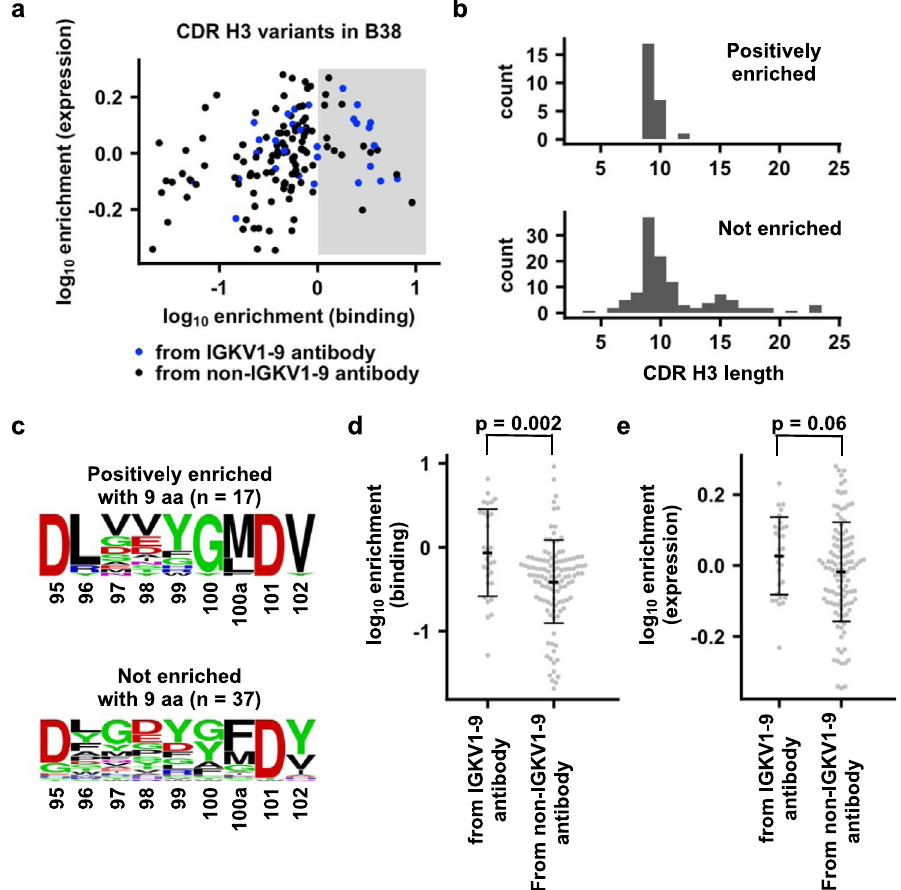
Fig. 4 Binding and expression pro fi ling of 143 CDR H3 variants in B38 antibody. a For each of the 143 CDR H3 variants, the enrichment in occurrence frequencies after FACS selections for binding to RBD and expression level are shown. Blue: CDR H3 variants that are derived from IGHV3-53/3-66 RBD antibodies that use IGKV1-9. Black: CDR H3 variants that are derived from IGHV3-53/3-66 RBD antibodies that do not use IGKV1-9. Shaded area indicates log 10 enrichment in binding >0. Data are from the average of n = 2 independent biological replicates. b The amino-acid length distribution of CDR H3 variants that are positively enriched in binding (log 10 enrichment in binding >0) or not (log 10 enrichment in binding ≤ 0) is shown. c Sequence logos are shown for CDR H3 variants with 9 aa (Kabat numbering) that are positively enriched or not enriched. d Comparison of log 10 enrichment in binding for CDR H3 variants from IGHV3-53/3-66 RBD antibodies that use IGKV1-9 and those that do not use IGKV1-9. e Comparison of log 10 enrichment in expression for CDR H3 variants from IGHV3-53/3-66 RBD antibodies that use IGKV1-9 and those that do not use IGKV1-9. d , e Two-tailed Student ’ s t -test was used to compute the p -value. Error bars represent standard deviations. The center horizontal bars represent the means. Enrichment in expression and binding, as well as count data are provided in Supplementary Data 2. Data are from the average of n = 2 independent biological replicates. Source data are provided in the Source data fi